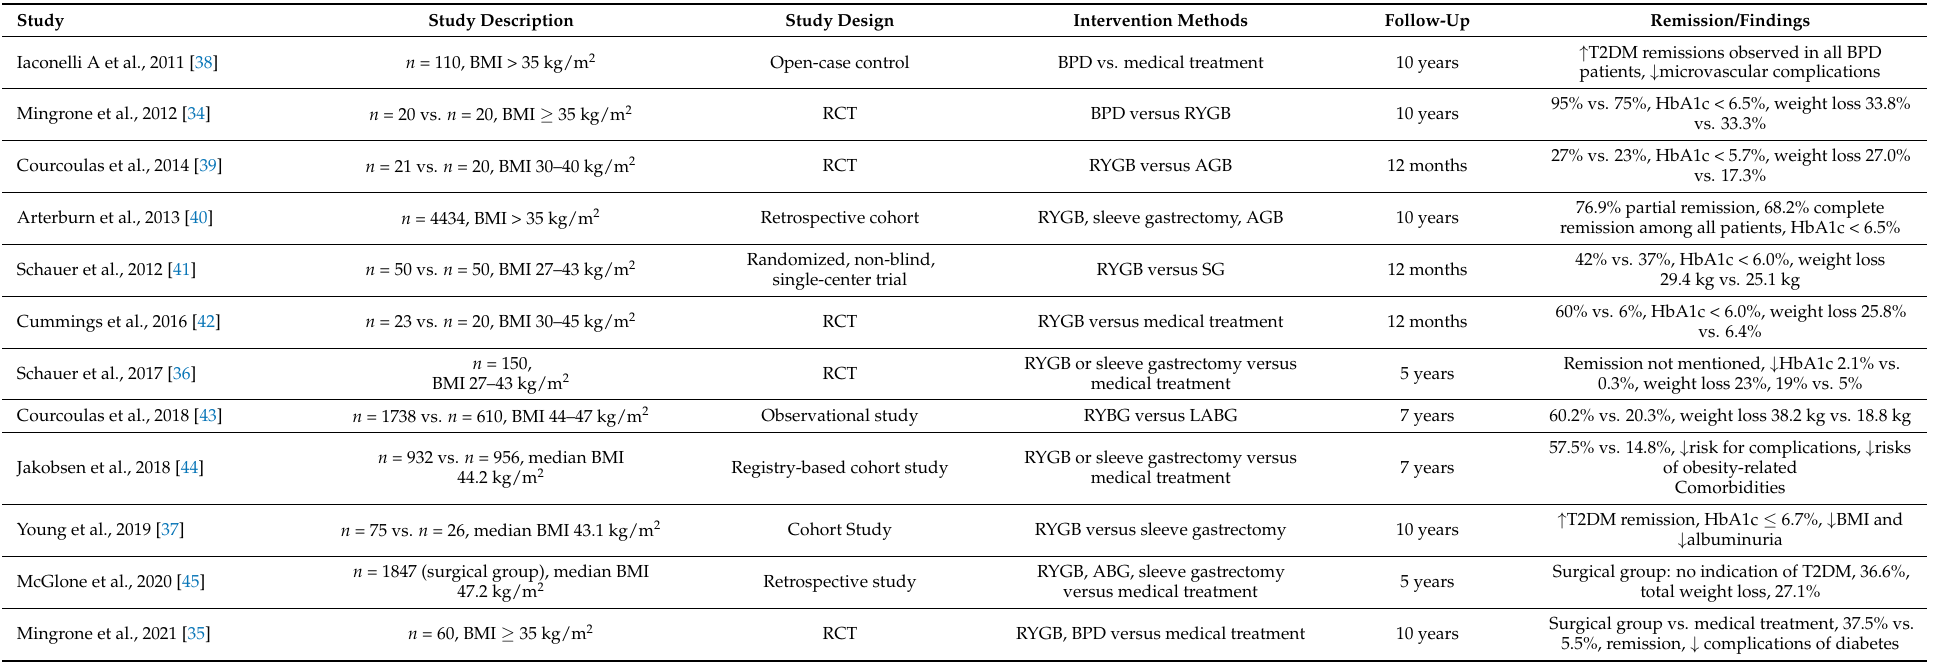
Table 1. Studies that have investigated the efficacy of metabolic surgery in inducing